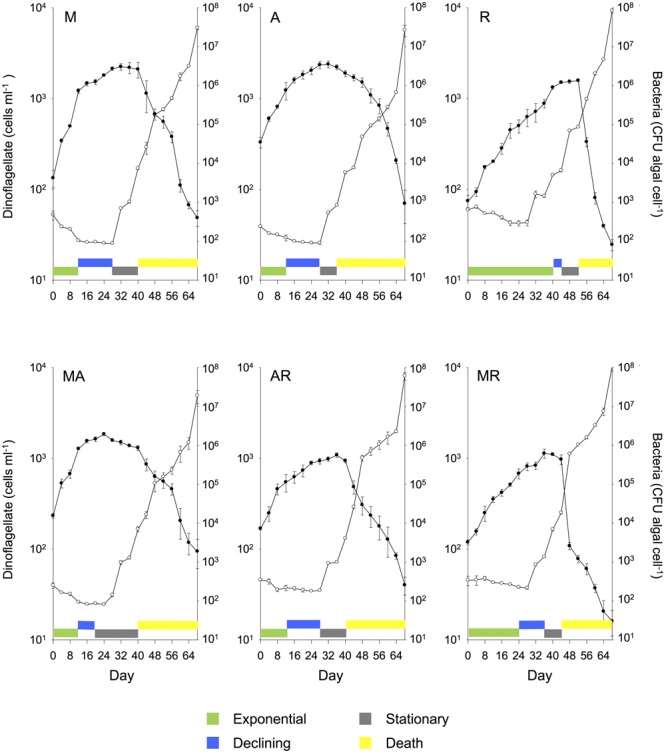
Mean (± SE) batch culture growth curves of G. catenatum (closed circles) and total bacteria (CFU algal cell-1, open circles) from duplicate cultures grown with single and pairwise combinations of bacterial associates (M, Marinobacter DG879; A, Alcanivorax DG881; R, Roseobacter DG874; MA, Marinobacter DG879 and Alcanivorax DG881; AR, Alcanivorax DG881 and Roseobacter DG874; MR, Marinobacter DG879 and Roseobacter DG874). See Table 1 for culture codes and additional details.